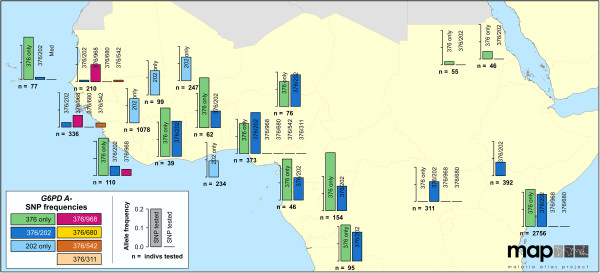
G6PD A- variant SNP frequency map for Africa (map series 2). Bar charts representing the frequencies of G6PD variants. The variants that were tested for in each location are listed above the x-axis. Empty spaces along the x-axis indicate that the named variant was tested for but not identified in the population sample. Survey locations are mapped to closest approximation at the point of origin of the plots and exact locations shown in Additional file 4. Sample size is listed under each plot. Equivalent maps of the Americas and Asia are Additional files 3 and 5.